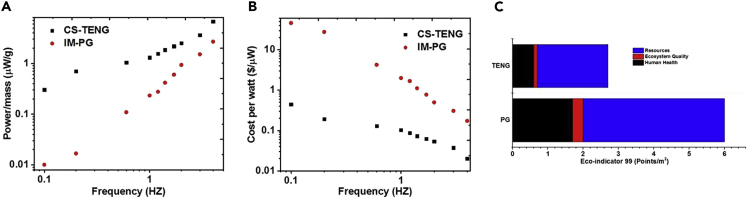
Specific Power, Cost per Watt, and Techno-Economic Analysis of TENG and PG(A) The average power-to-mass ratio of PG and TENG.(B) The cost per watt of PG and TENG.(C) Eco-indicator 99 results for 1 m2 of each mode. The data for TENG is extracted from the study of Ahmed et al., 2017. The data for PG is extracted from the study of Ibn-Mohammed et al. (2016).